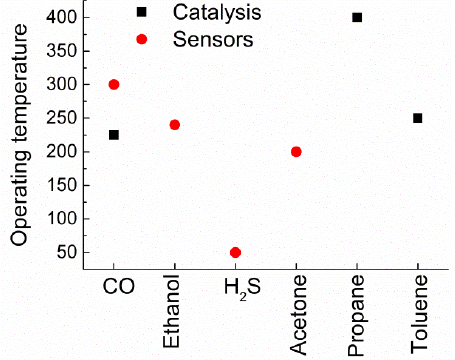
Figure 5. Typical operating temperatures for the indicated sensing and catalytic experiments with Fe 2 O 3 materials, as found in the literature. The crosses indicate the applications where no adequate references could be found. The references are reported in the